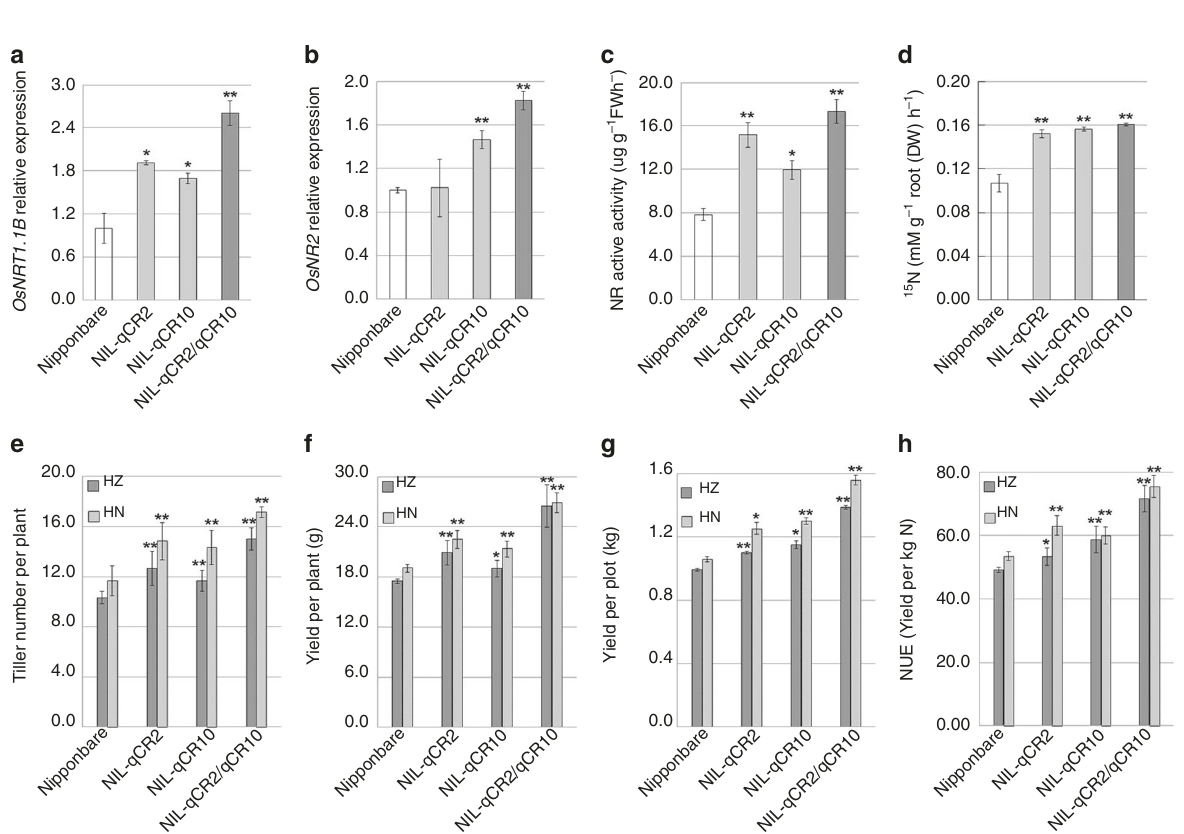
Fig. 5 OsNR2 and OsNRT1.1B interact to promote rice yield and NUE. a root OsNRT1.1B mRNA abundance, b leaf OsNR2 mRNA abundance, c leaf NR active activity, d 15 NO 3 − uptake activity of roots exposed to 1.25 mM 15 NO 3 − , e effective tiller number, f yield per plant, g yield per plot and h NUE of Nipponbare, NIL- qCR2 , NIL- qCR10 and NIL- qCR2/qCR10 . Values are mean ± s.d. ( n = 3 for a – d , n = 6 for e , f , h and n = 2 for g ). Error bar represents s.d. Plants cultivated in fi eld conditions with NO 3 − fertilizer (14 kg per acre) as major N source e – h . * and ** respectively indicate least signi fi cant differences at the 0.05 and 0.01 probability levels, compared with Nipponbare. HZ: Hangzhou (harvested on September 20th, 2018); HN: Hainan (harvested on April 20th, 2019). Source data are provided as a Source Data fi